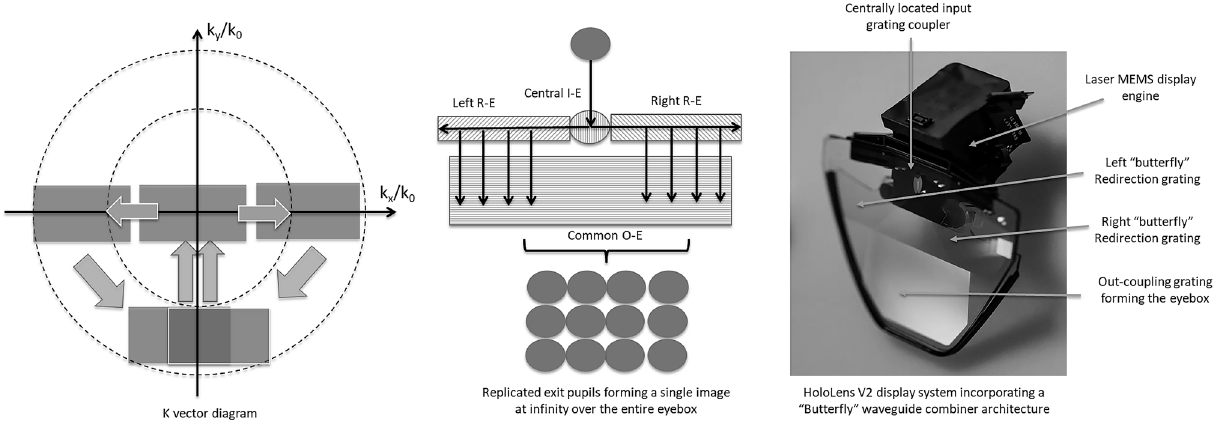
Figure 29: Symmetric incoupling for FOV increase in the direction of incoupling.